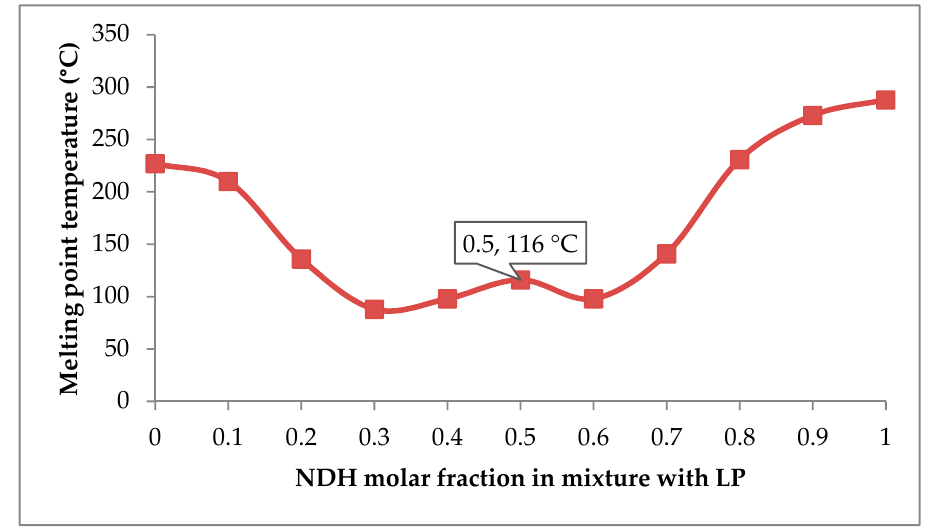
Figure 1. Phase diagram of diclofenac sodium hydrate (NDH) and L-proline (LP) composed from a series of molar ratios, represented by the molar fraction of NDH in the mixture towards the melting point.